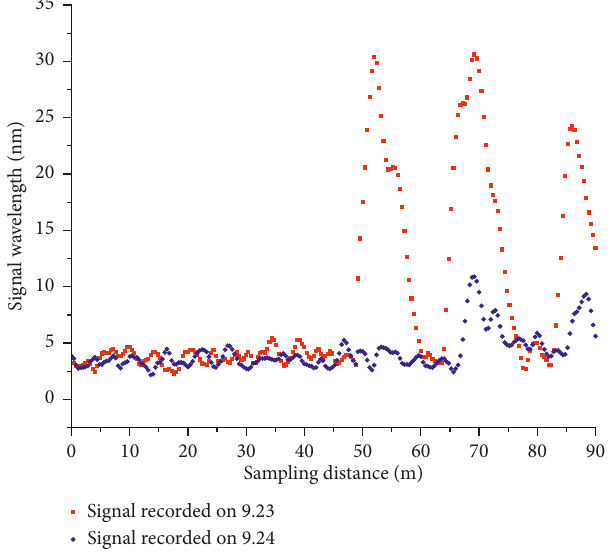
Figure 13: Vibration signal over sampling distance. Table 5: Right track line on-site measurement conditions.